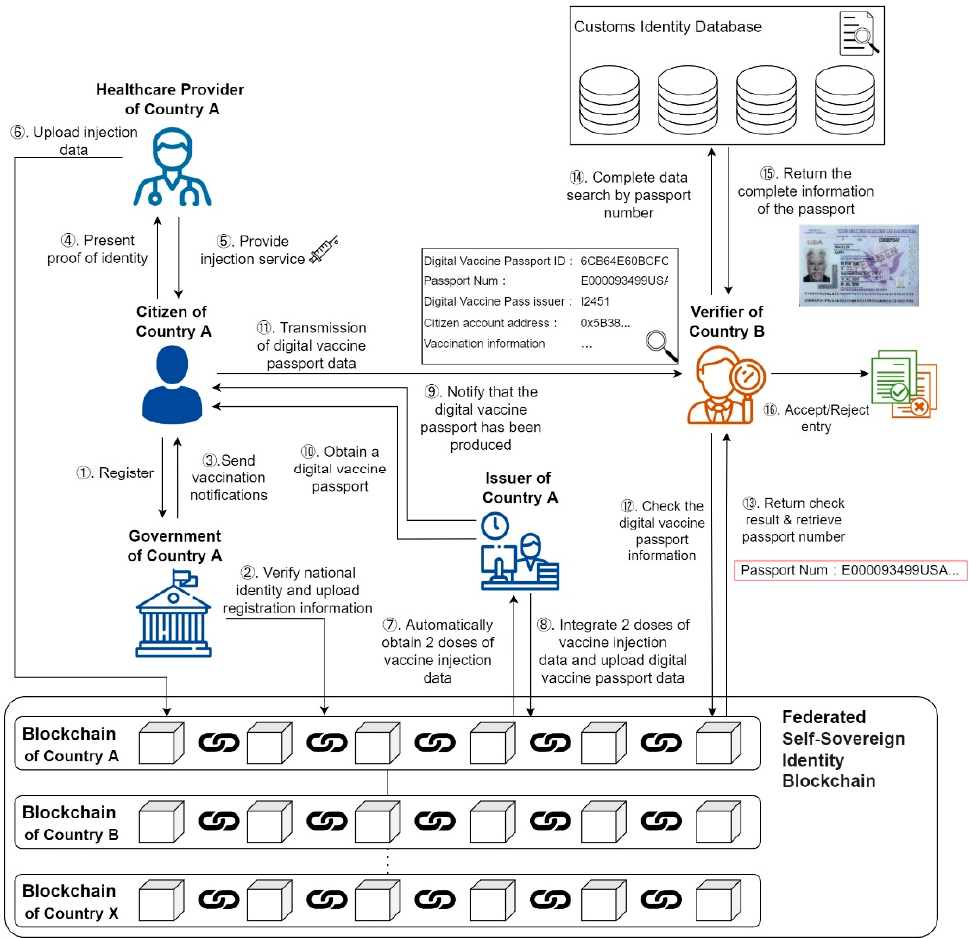
Figure 3. Scenario diagram of the Federal Hyperledger verification framework.